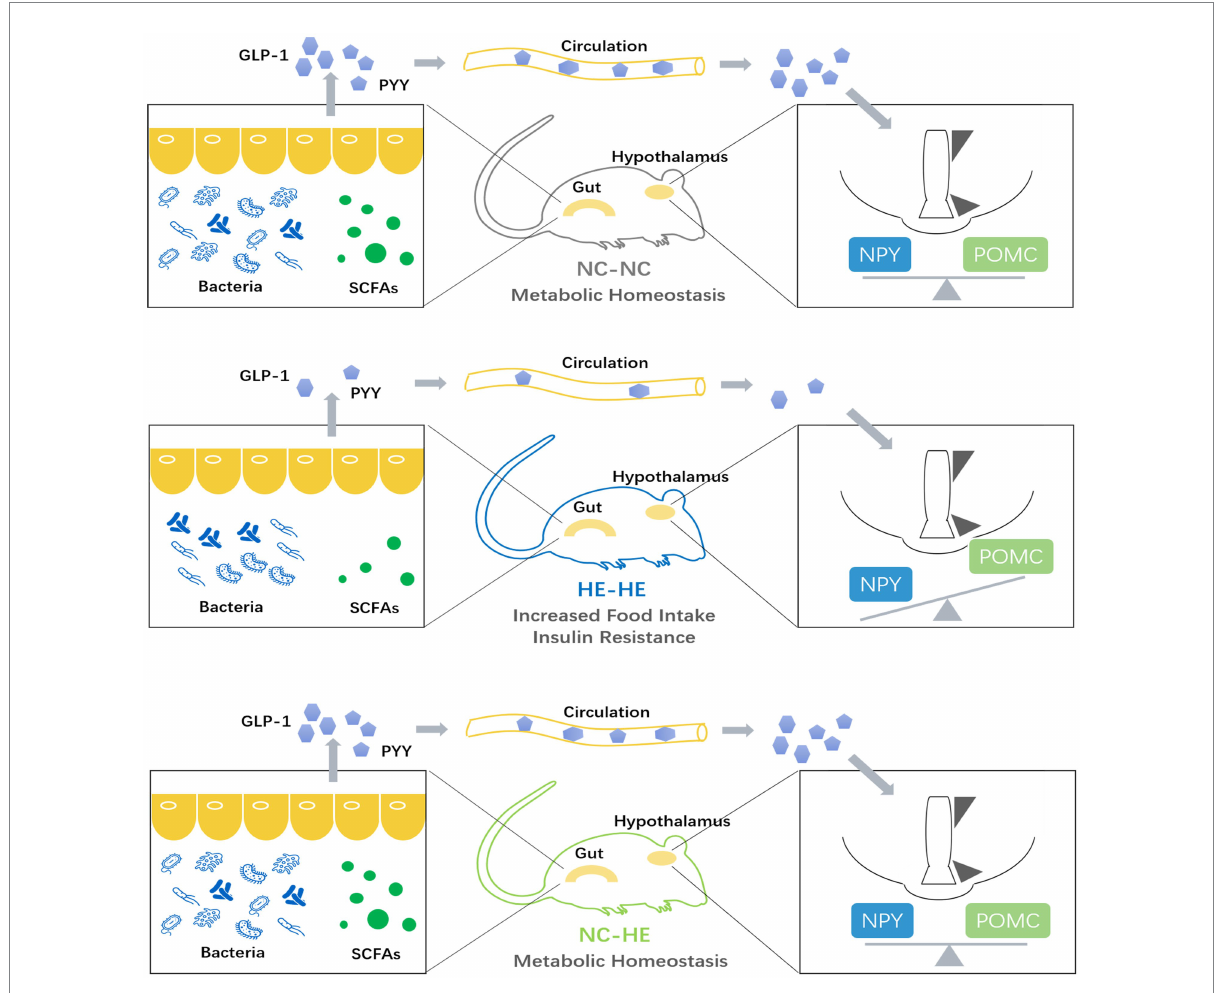
FIGURE 6 Model illustrating the role of the microbiota-gut-brain axis in the prevention of prenatal high estradiol-induced insulin resistance by surrogate